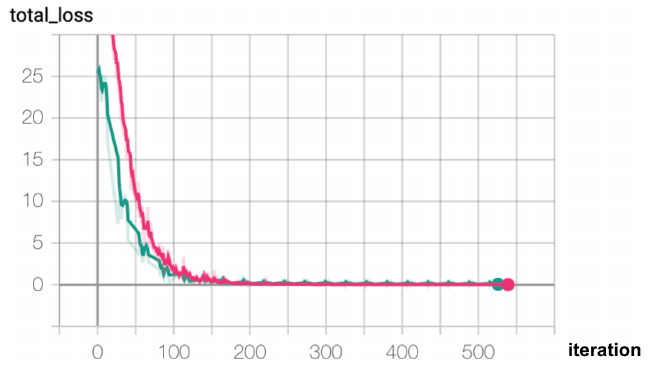
Figure 9. Training (magenta) and validation (green)